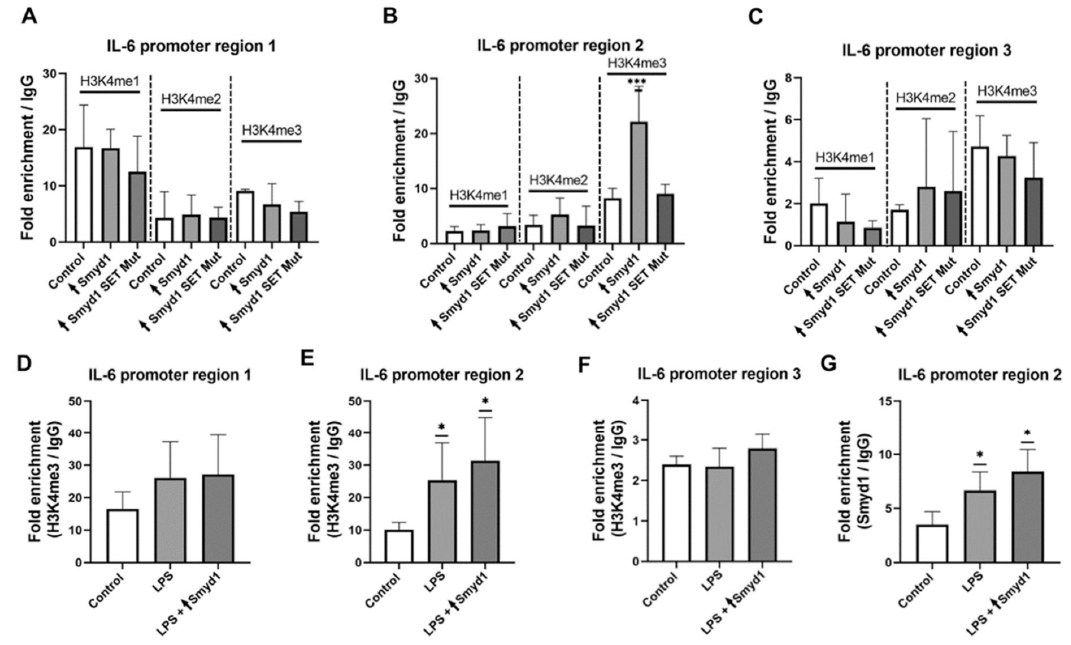
Figure 6. Smyd1 increases the H3K4me3 methylation status in the region 2 upstream of the transcription start site (TSS) within the IL ‐ 6 promoter. ( A – C ) ChIP assays were used to assess the degree of methylation of histone H3 atK4 (H3K4me1, H3K4me2 and H3K4me3) within the regions 1 ‐ 3 of the IL ‐ 6 promoter in EA.hy926 cells that were transfected with either a pCMV2 ‐ Smyd1 ‐ flag vector ( ↑ Smyd1) or a vector with a mutant Smyd1 gene lacking methylation activity due to a point mutation within the SET domain ( ↑ Smyd1 SET mutant). An unrelated methylation ‐ susceptible chromatin region with the GAPDH gene was included as a control in the ChIP ‐ qPCR experiments. Three regions were selected: region 1 ( − 1469 to − 1238; ( A )), region 2 ( − 638 to − 346; ( B )) and region 3 (+150 to +347; ( C )). The results were normalized to the negative ( IgG ) sample. n = 4. *** p < 0.001 using one ‐ way ANOVA. ( D – F ) ChIP assays were used to assess the enrichment of the methylation site H3K4me3 within the IL ‐ 6 promoter in EA.hy926 cells that were transfected with a pCMV2 ‐ Smyd1 ‐ flag vector alone ( ↑ Smyd1) or in combination with LPS (1 μ g/mL) stimulation for 24 (LPS + ↑ Smyd1). n = 3. * p < 0.05 using one ‐ way ANOVA. ( G ), ChIP ‐ qPCR for the Smyd1 level within the region 2 of the IL ‐ 6 promotor. n = 3. * p < 0.05 using one ‐ way ANOVA. Data are shown as mean ± SD.